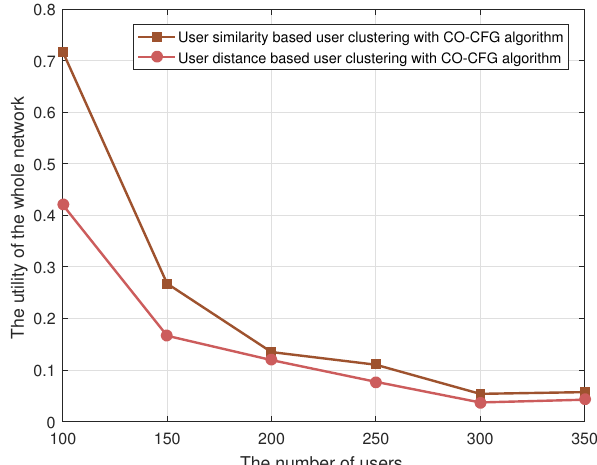
Figure 3. The utility of the whole network with varying the user clustering